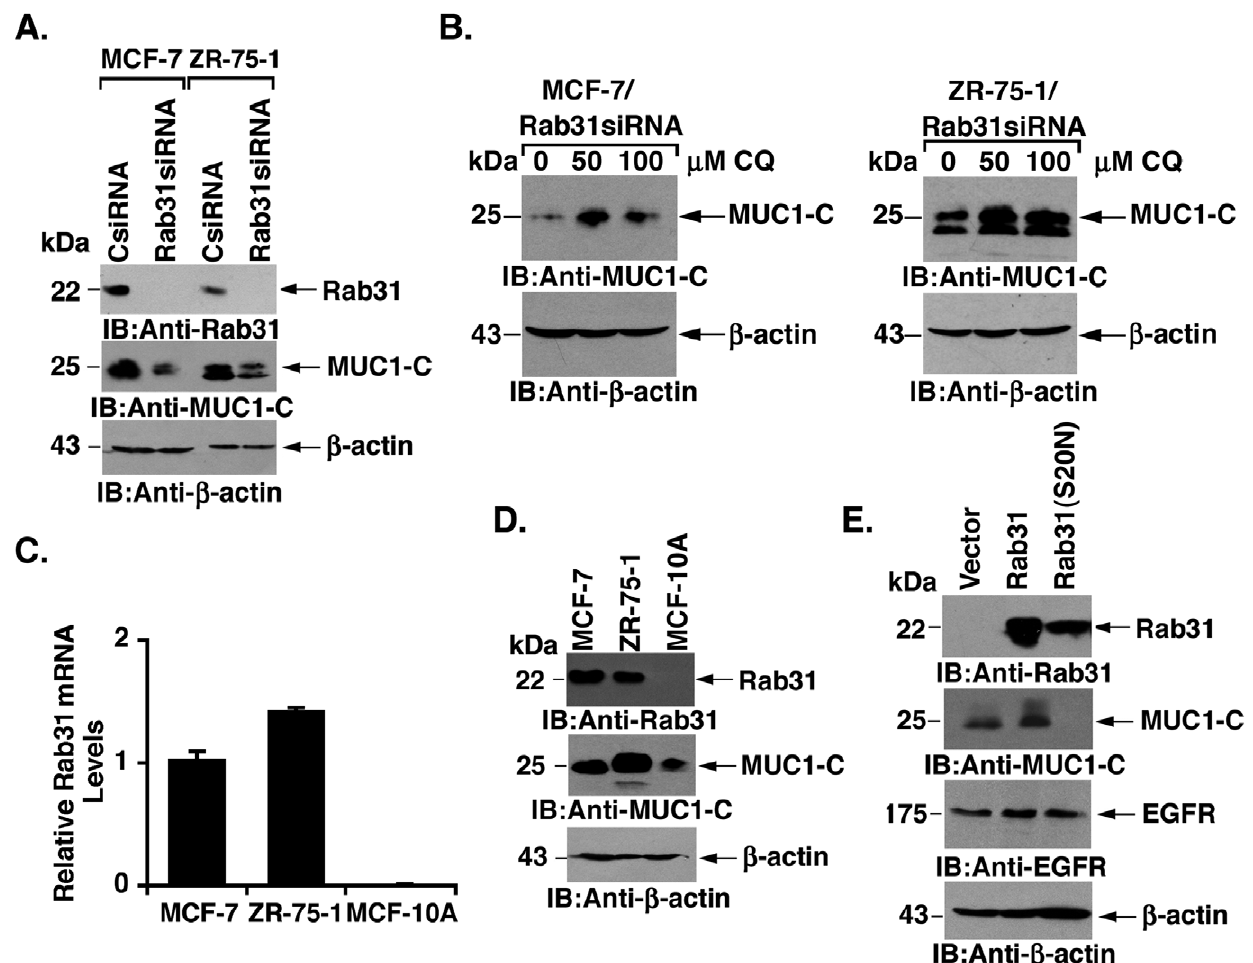
Figure 5. Rab31 upregulates MUC1-C expression. A. MCF-7 (left) and ZR-75-1 (right) cells were stably transfected to express a control siRNA (CsiRNA) or a Rab31 siRNA. Lysates from the transfectants were immunoblotted with the indicated antibodies. B. MCF-7/Rab31siRNA (left) and ZR-75- 1/Rab31siRNA (right) cells were treated with the indicated concentrations of chloroquine (CQ) for 24 h. Lysates from the treated cells were immunoblotted with the indicated antibodies. C. RNA from MCF-7, ZR-75-1 and MCF-10A cells was analyzed for Rab31 mRNA levels by qRT-PCR. The results (mean + SD of three determinations) are expressed as relative Rab31 mRNA levels compared to that obtained for MCF-7 cells. D. Lysates from MCF-7, ZR-75-1 and MCF-10A cells were immunoblotted with the indicated antibodies. E. MCF-10A cells were stably transfected to express an empty vector, Rab31 or Rab31(S20N). Lysates from the transfected cells were immunoblotted with the indicated antibodies.